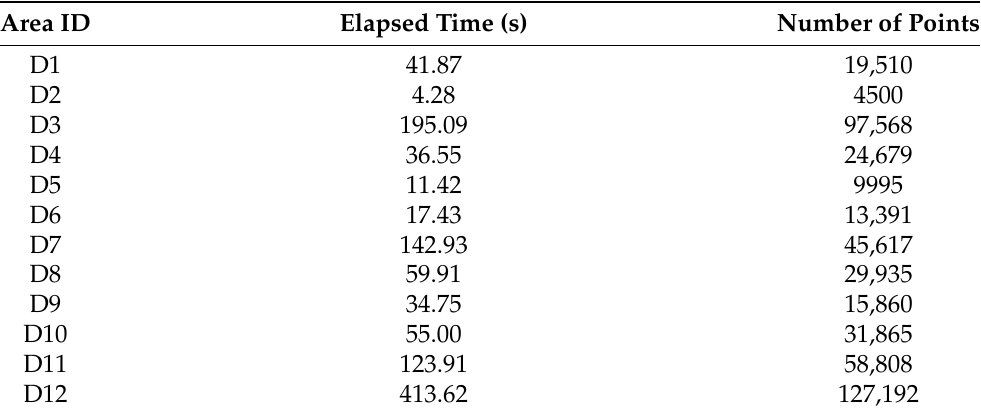
Table 3. Elapsed time and number of points of the input point cloud for each study area. In the reported cases, the clipping radius is equal to 20 m.